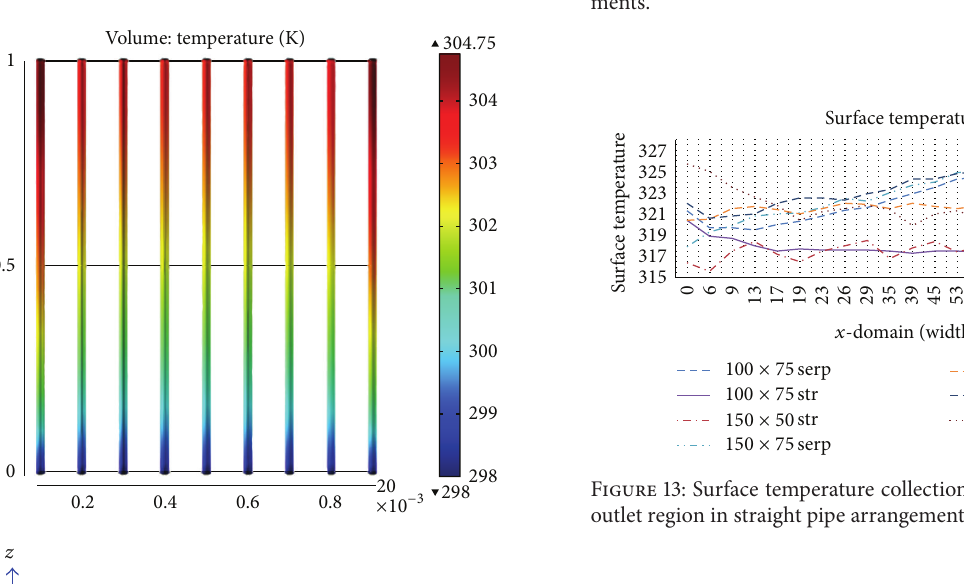
Figure 12: Outlet water temperature for different pipe arrange- ments.